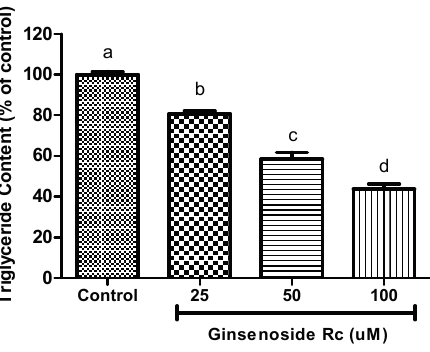
Figure 2. Effect of different Rc concentrations on the accumulation of triglyceide in adipocytes. Results are representative of three independent experiments, and statistically significant data are expressed as p < 0.05. a–d Significant difference in treatment concentrating to ANOVA followed by Duncan ( p < 0.05).